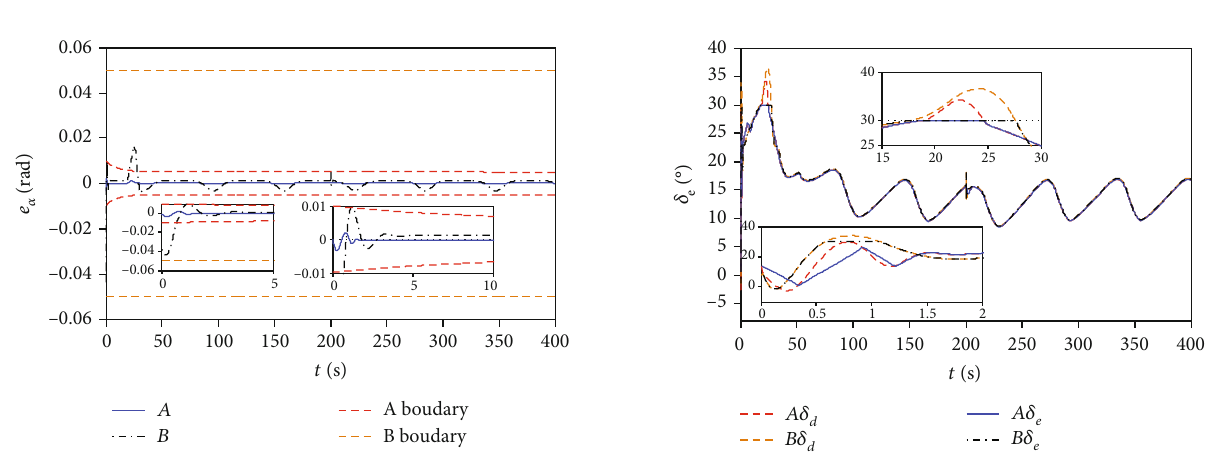
Figure 10: Curves of elevator angular de fl